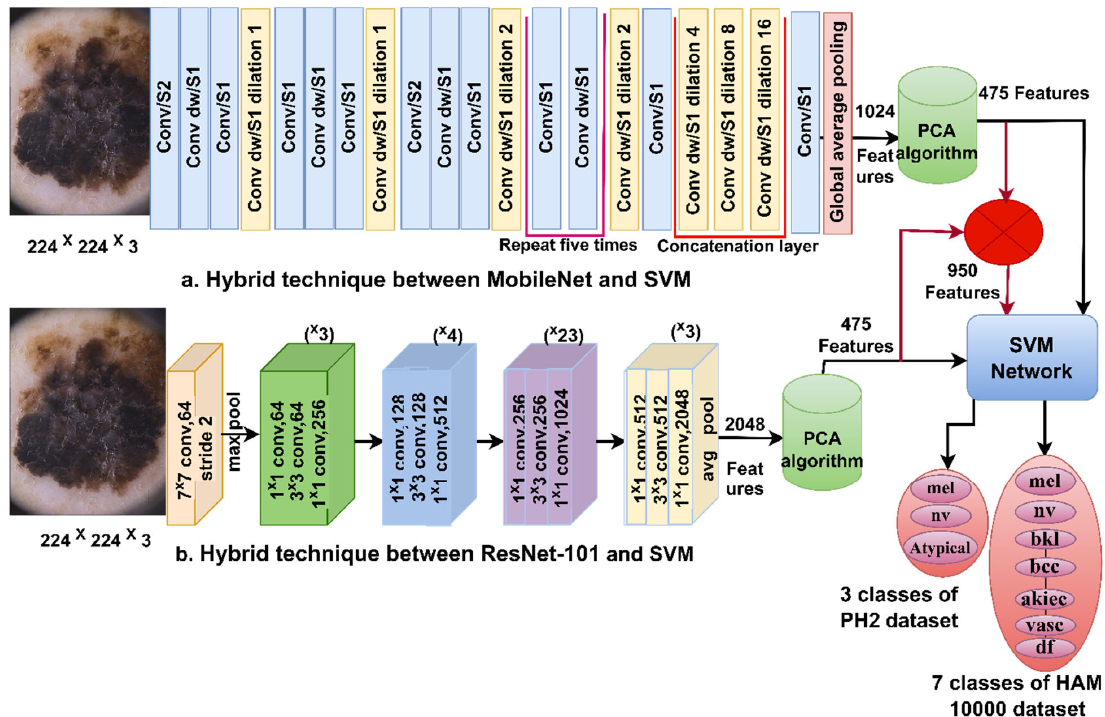
Figure 5. Structure of the hybrid technique for dermoscopic image analysis of the HAM10000 and PH2 datasets.